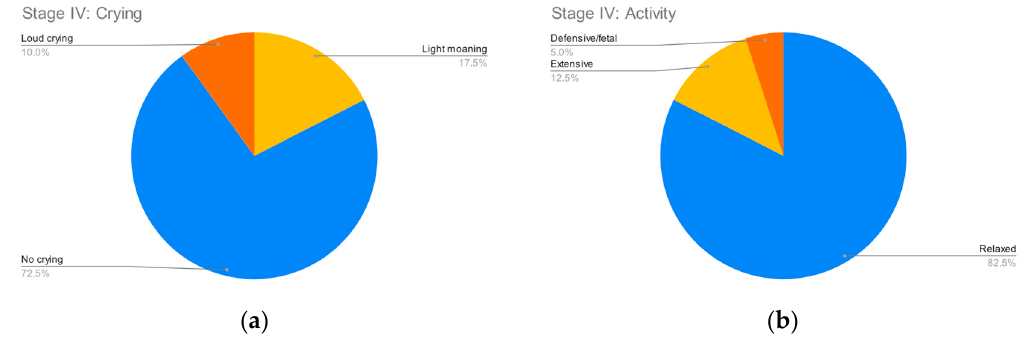
Figure 5. Stage IV parameters. ( a ) Crying; ( b ) Activity.